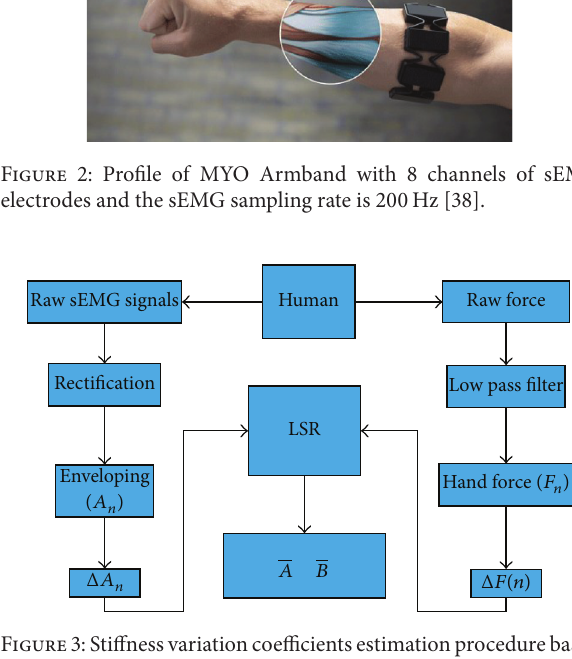
Figure 3: Stiffness variation coefficients estimation procedure based on force-sEMG linear